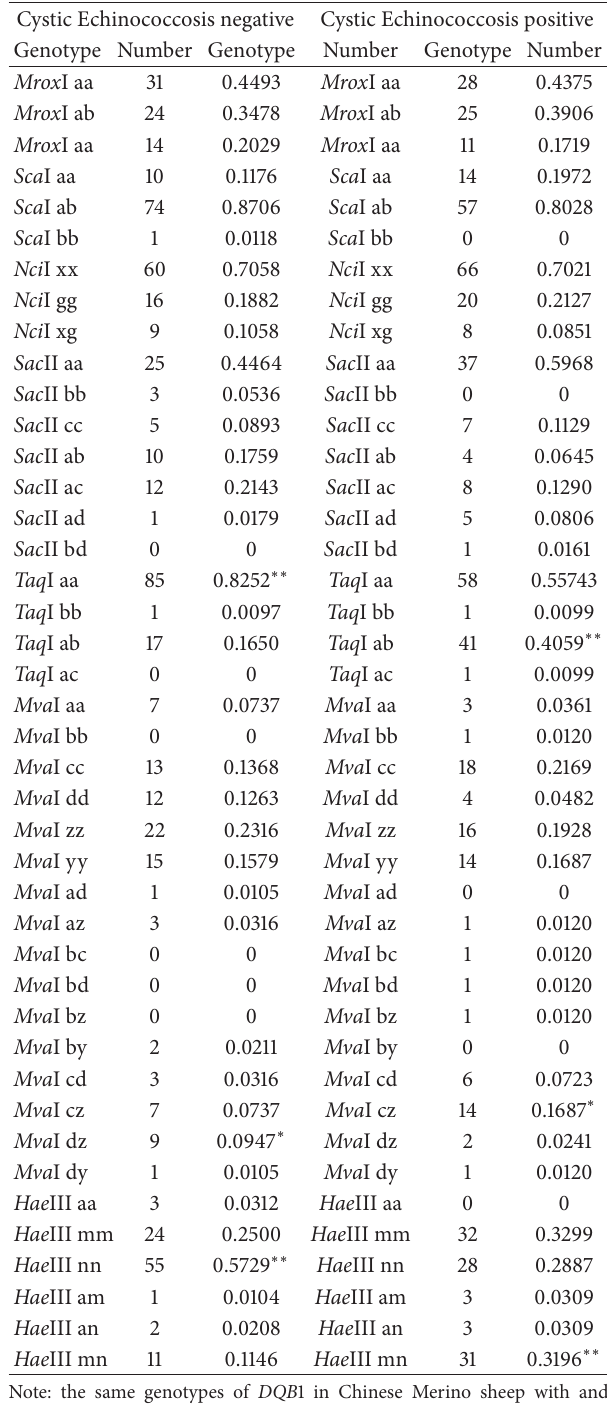
Table 2: Genotypic frequencies of DQB1 in Chinese Merino sheep with and without Cystic